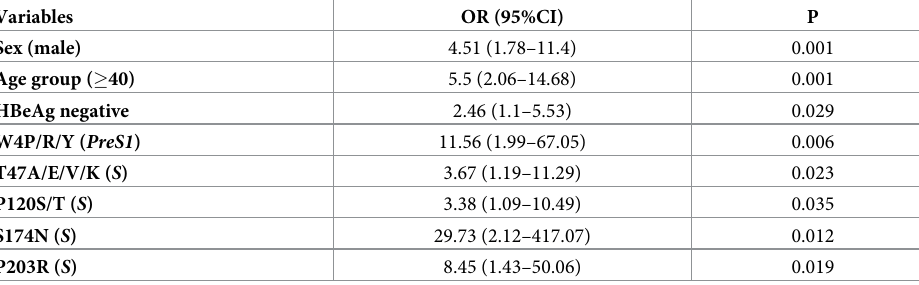
Table 6. Multivariable analysis for related factors to HCC (n =